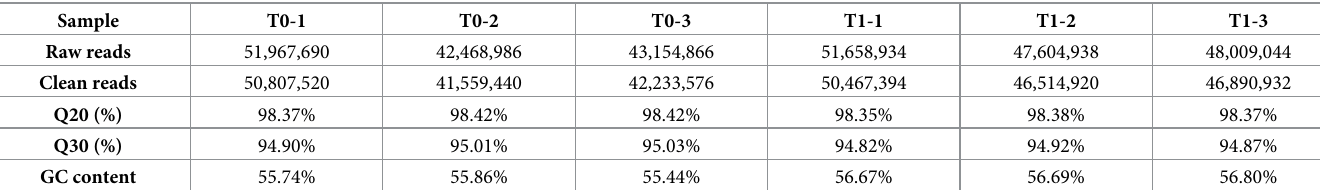
Table 1. Statistics of sequencing data quality from Pennisetum setaceum ‘Rubrum’ samples.